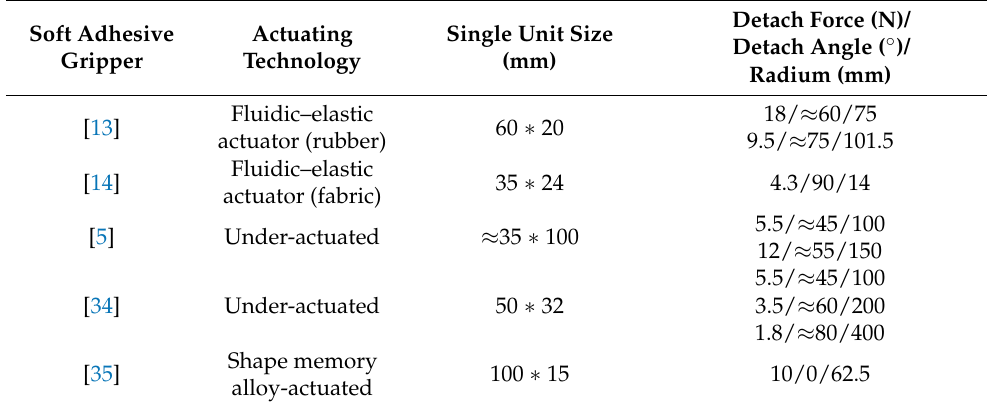
Table 1. Comparison of the adhesion performance of the existing adhesive grippers consisting of soft adhesive